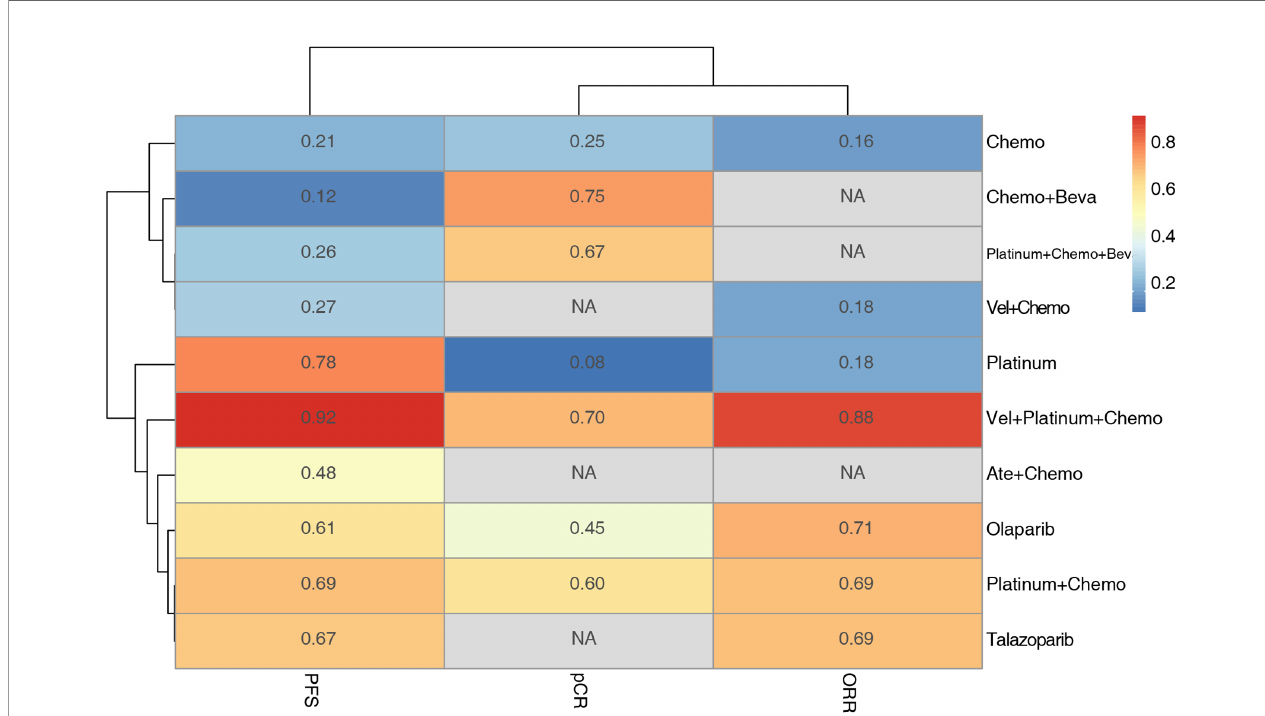
FIGURE 6 | Hierarchical clustering of PFS pCR and ORR results based on the P-score. The numbers and colors in the grid represent the P-score value of each intervention method for each outcome, and the lines on the left and upper side represent the similarities among the elements by K-means cluster